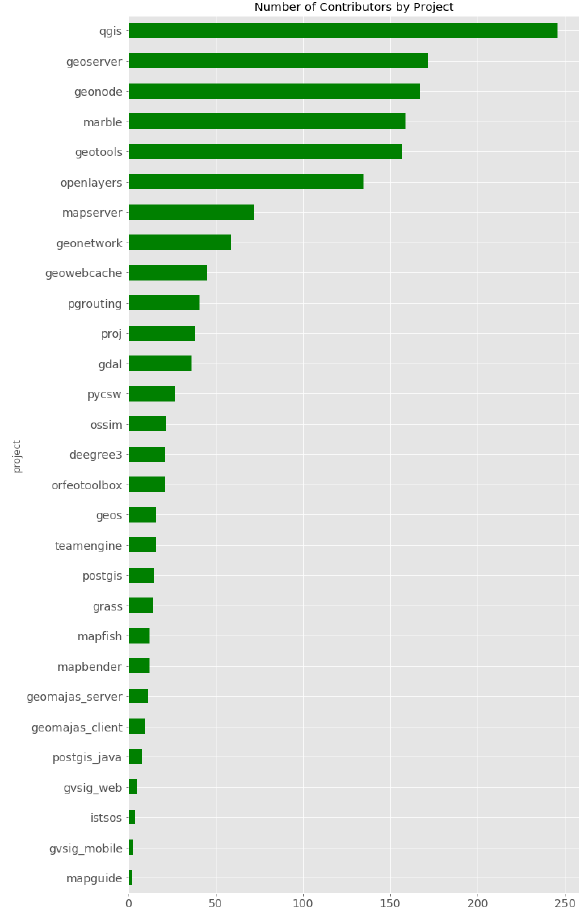
Figure 1. Count of total contributors by project